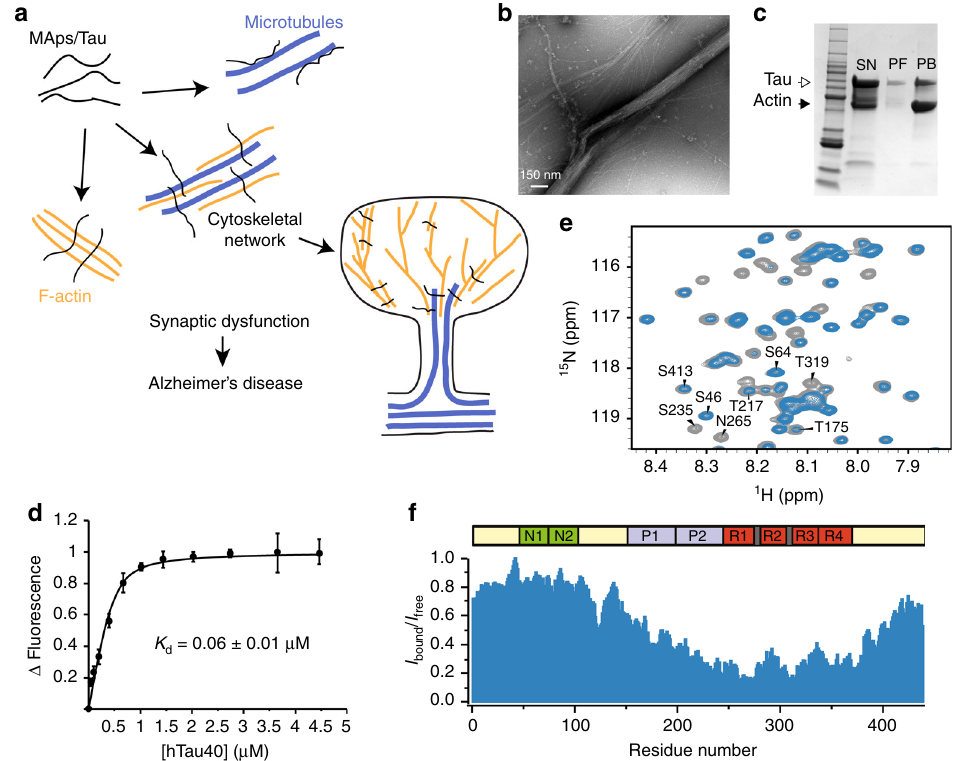
Fig. 1 Tau interacts with and bundles fi lamentous actin. a Schematic representation of the importance of MAPs for the cellular cytoskeleton. MAPs (black) regulate microtubule dynamics (blue), bundle actin fi laments (yellow), and cross-link actin fi laments and microtubules. Aberrant interaction of Tau with F- actin is associated with synaptic dysfunction in Alzheimer ’ s disease. b Electron micrograph of actin bundles induced by Tau. c Differential centrifugation in combination with a 4 – 20% gradient gel shows that Tau is associated with actin bundles. Lanes correspond to supernatant (SN), single fi laments (PF), and bundles (PB). Open and fi lled arrowheads mark Tau and actin bands, respectively. d Af fi nity of the Tau/F-actin interaction measured by fl uorescence using NBD-labeled F-actin. Error bars represent s.d. from three experiments. e Selected region of two-dimensional 1 H- 15 N HSQC spectra of 441-residue Tau in the absence (gray) and presence of a two-fold excess of F-actin (blue). f Residue-speci fi c changes in 1 H- 15 N HSQC signal intensities of Tau upon addition of F-actin (shown in e ). I free and I bound are intensities in the absence and presence of a two-fold excess of